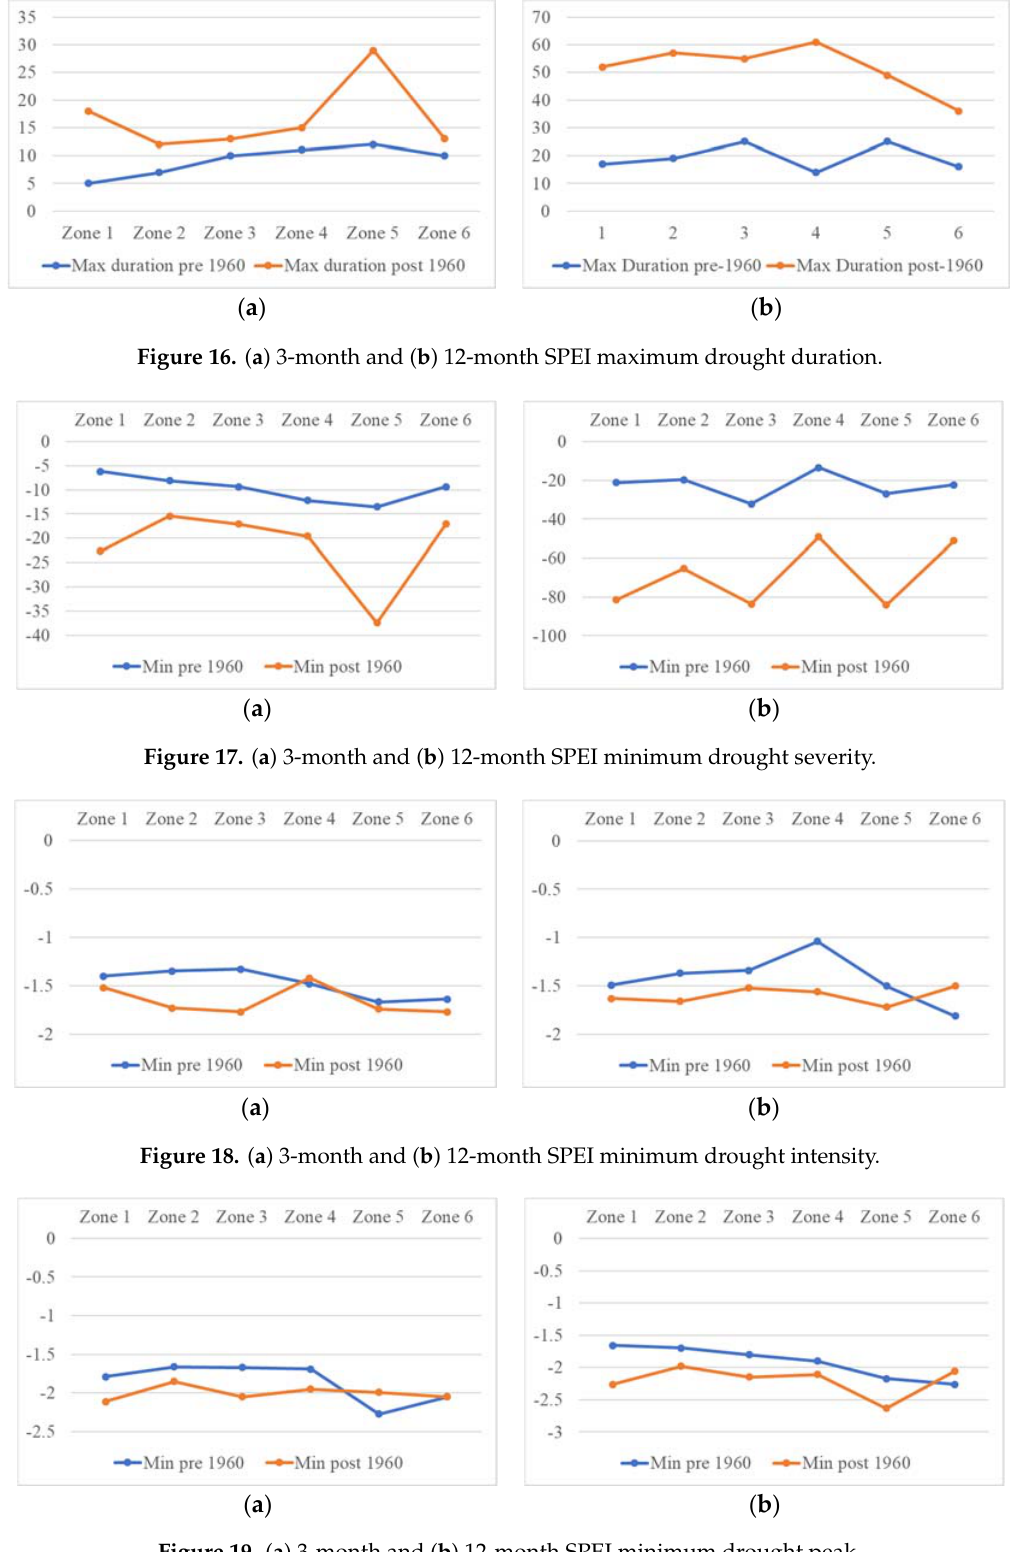
Figure 15. ( a ) 3 ‐ month and ( b ) 12 ‐ month SPEI drought counts.